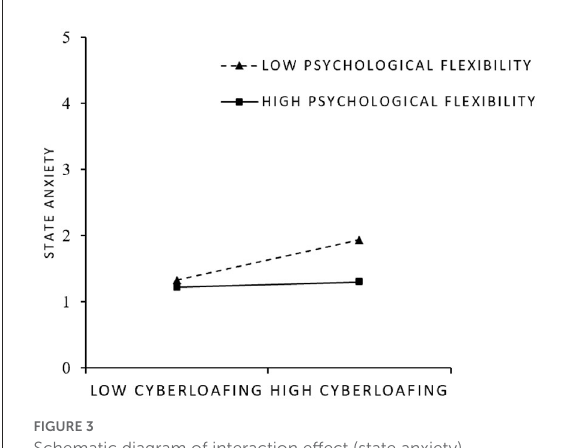
FIGURE3 Schematic diagram of interaction effect (state anxiety).